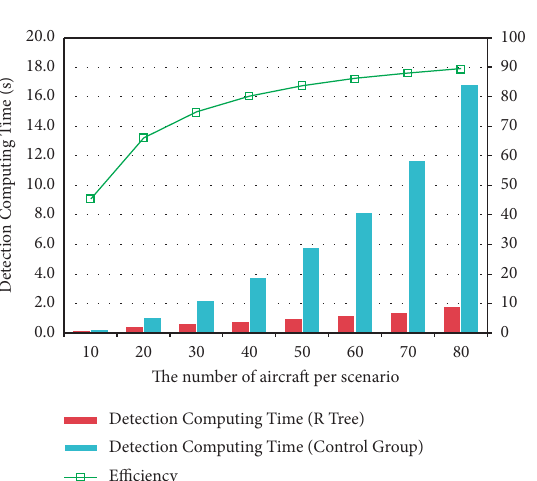
Figure 10: The relationship of mean computing time/efficiency and the number of aircraft per